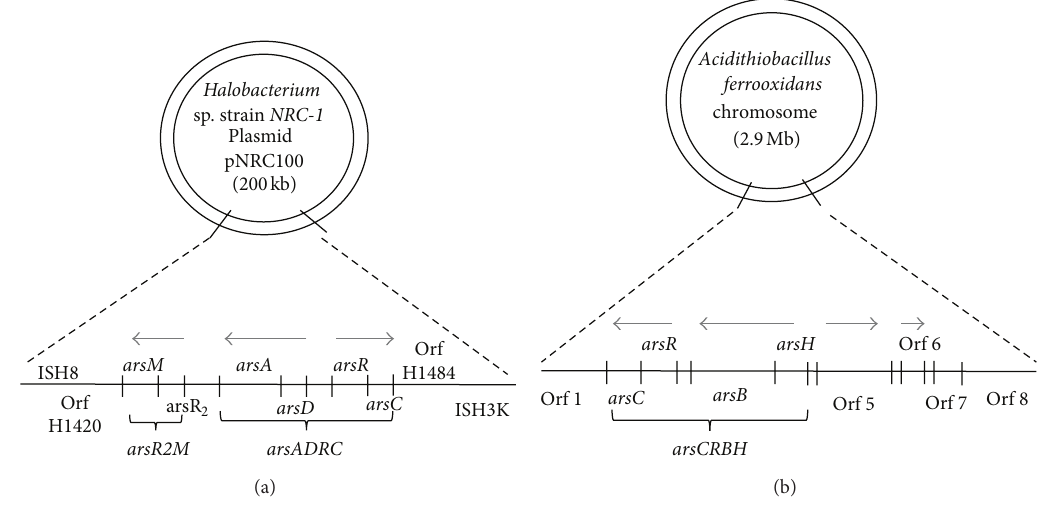
Figure2:Arsenicresistanceisdeterminedbythepresenceof ars operon,whichcodesforanarseniteP 1 -typeATPasestransporterArsA/ArsB, an arsenate reductase ArsC, and arsenite responsive repressors ArsD and ArsR. The arsADRC and arsR2M operons are present on the plasmid in haloarchaeon Halobacterium sp. strain NRC-1 (a). The acidophilic bacterium Acidithiobacillus ferrooxidans has chromosomally encoded arsCRBH (b). The unique feature of these operons is the bidirectional nature transcription. Table 3: Annotated transporters for various metals in haloarchaeal genomes. Ten haloarchaeal genomes have been completely sequenced while others are partially sequenced. All these organisms have been annotated with transporters belonging to the following type of -type ATPases, cation diffusion facilitator (CDF) family, and ATP-binding cassette (ABC) family. The transporters-cation efflux type, P 1B most abundant transporters were for iron followed by copper. Only one haloarchaeon, Halogeometricum borinquense , was annotated with silver transporters [135].